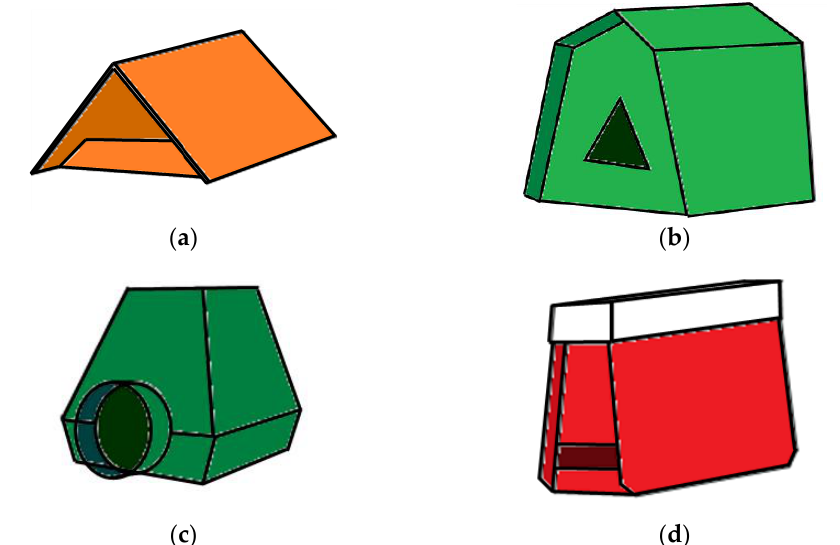
Figure 1. ( a ) Sketch of a standard delta trap used for codling moth trapping in pome fruit crops adapted from [20]. Other sketches ( b – d ) are adaptations of commercially available remote monitoring traps equipped with imaging systems for codling moth monitoring [21 – 23].